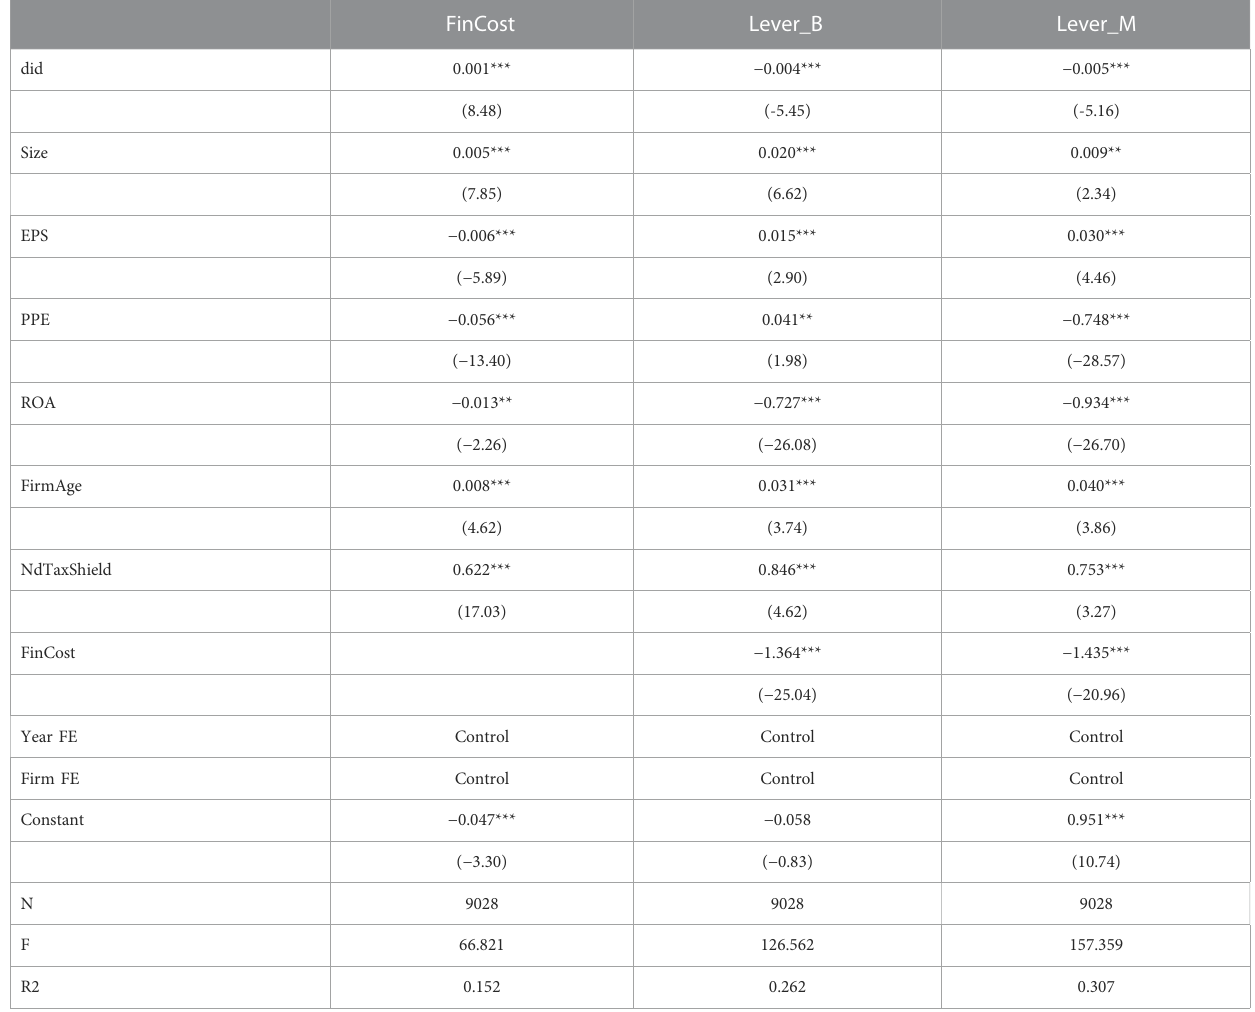
TABLE 8 Carbon trading, debt fi nancing costs and capital